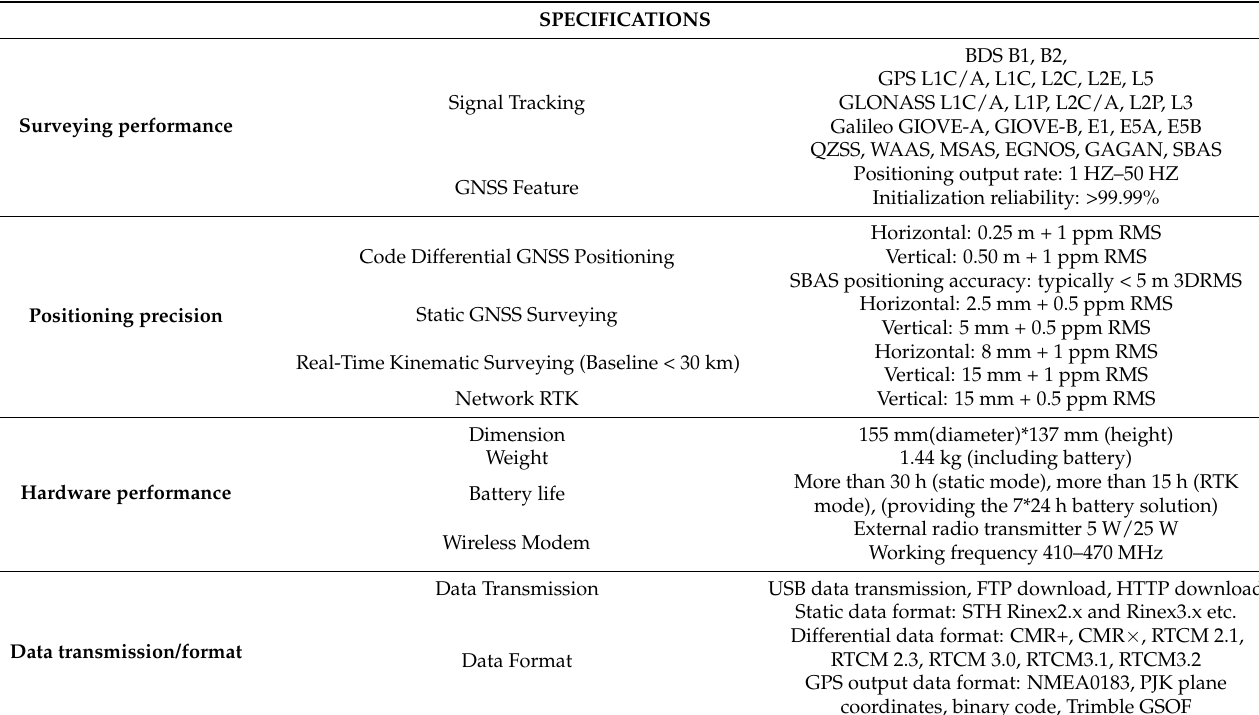
Figure 2. ( a ) The Galaxy 6 RTK GNSS and ( b ) the acquisition of tree location information in the field. (The measured and reference values of the tree location information were obtained 30 cm south of the tree.). Table 1. Technical specifications of the Galaxy 6 RTK instrument.